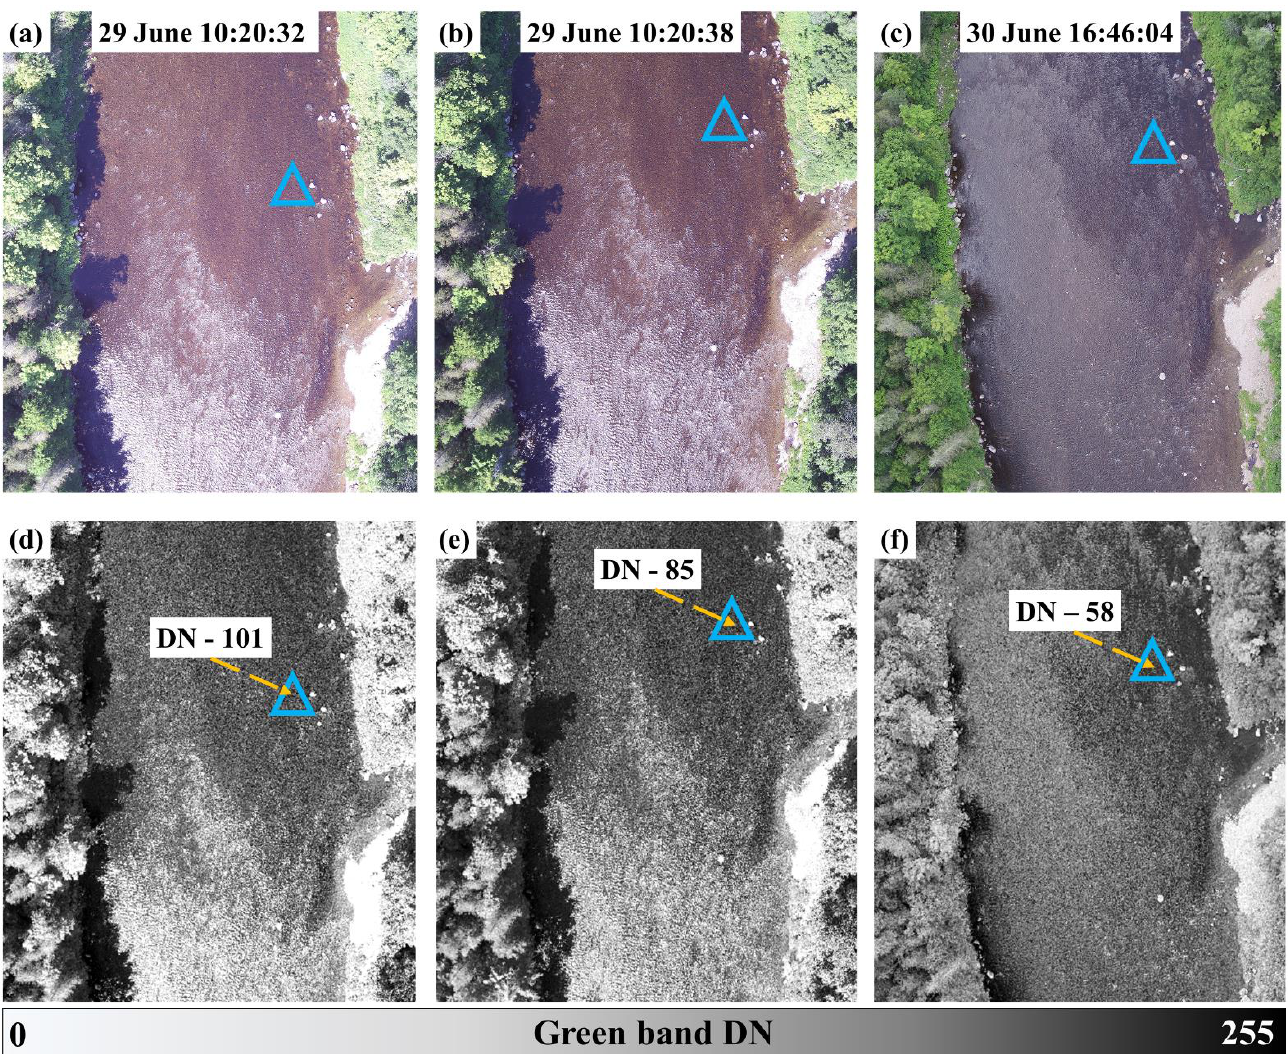
Figure 6. Light conditions varied at the intra-flight timescale as is shown in ( a , b ), and also varied at the inter-flight (daily) scale ( c ) — where all images are from the R s optical sensor. These changes led to variability in the images’ reflectance, as is shown by the corresponding green band digital number (DN) — ( d – f ). Here, high DN values denote high reflectance, and thereby low emittance, whilst low DN values detail low reflectance and high emittance. The blue triangles delimit the region where a pixel value was extracted from the green band, and the yellow arrows point to the location of the corresponding DN values shown in ( d – f ).